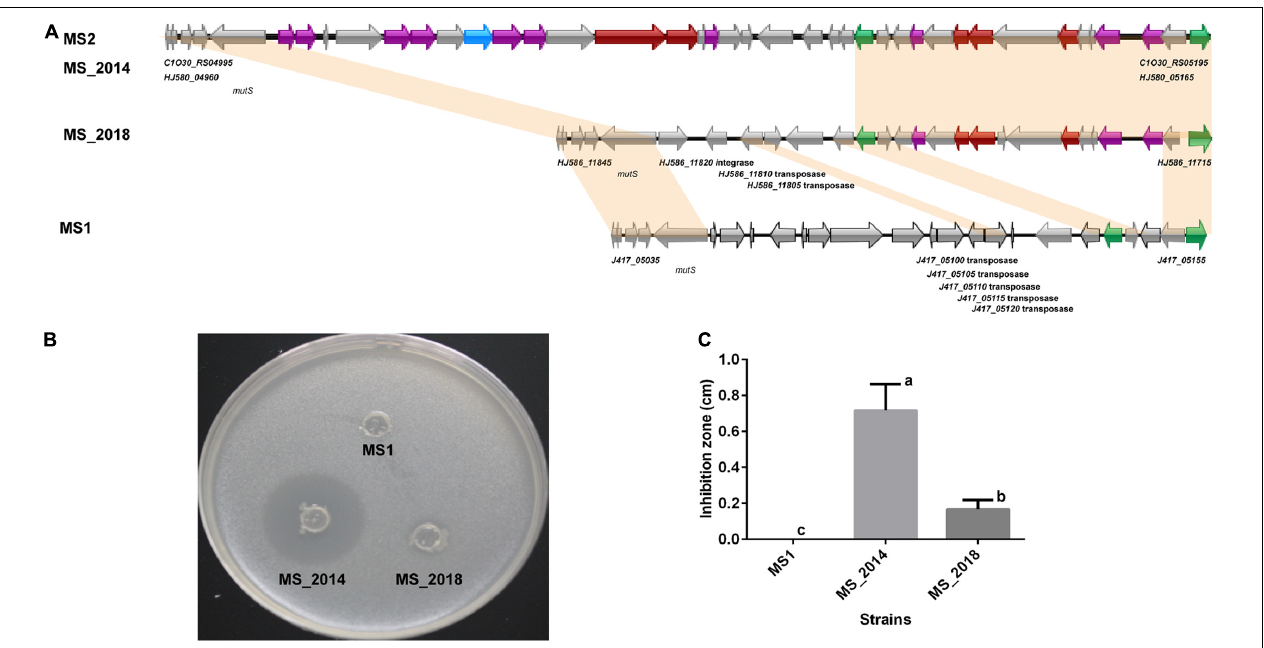
FIGURE 4 | Comparison of the bacteriocin biosynthetic gene cluster and related phenotype among D . zeae strains isolated from banana. (A) Genomic organization of bacteriocin biosynthetic gene clusters (genes aligned with a shadow are homologous): core biosynthetic genes, additional biosynthetic